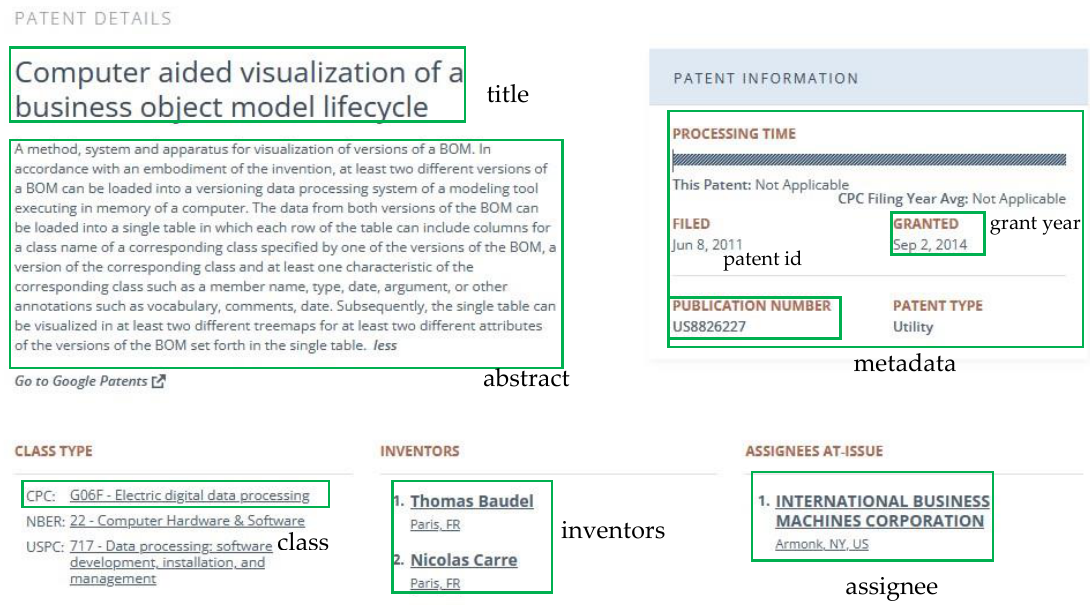
Figure 2. Example of USPTO patent entry.